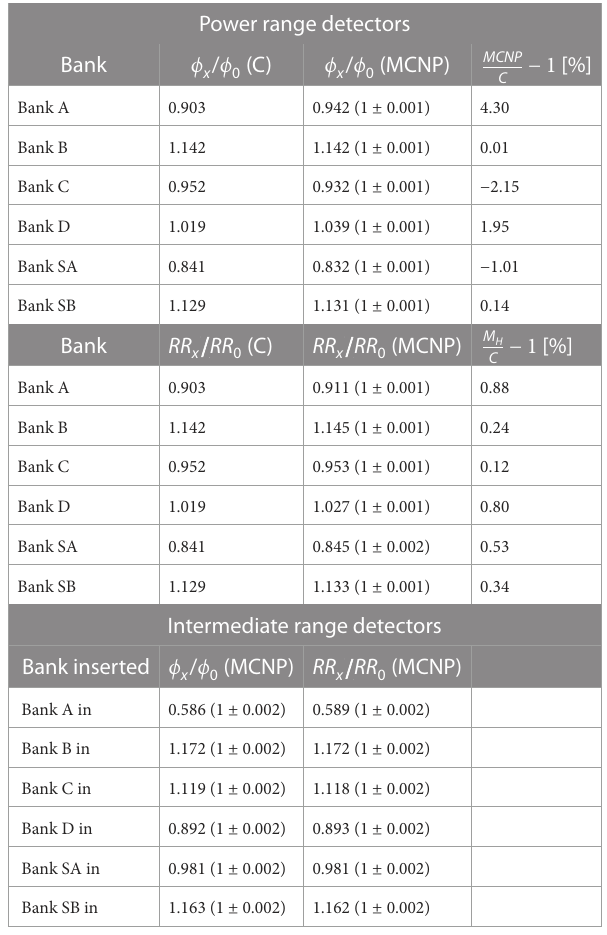
TABLE5 Calculatedneutronfluxredistributionfactors ( ϕ x / ϕ 0 ) andreaction rateredistributionfactors ( RR x / RR 0 ) forpowerandintermediaterange detectors,where C denotescurrentlyusedvaluesand MCNP represents